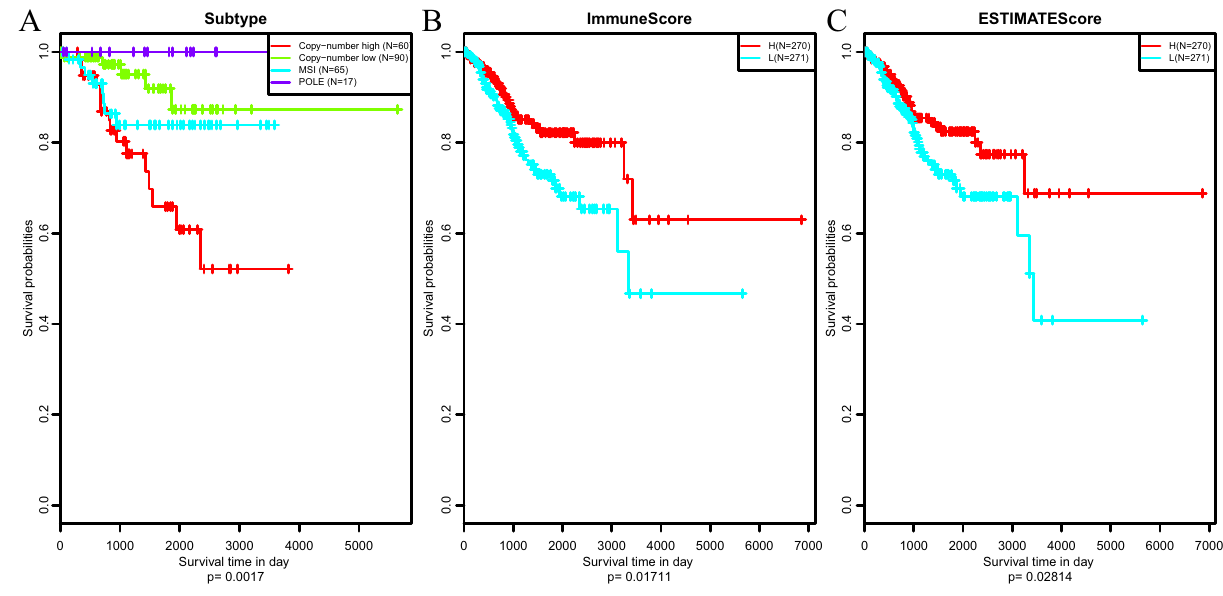
Figure 3. Prognosis of EC patients with different molecular subtypes ( A ), ImmuneScores ( B ) and ESTIMATEScores ( C ). H: high-risk; L: